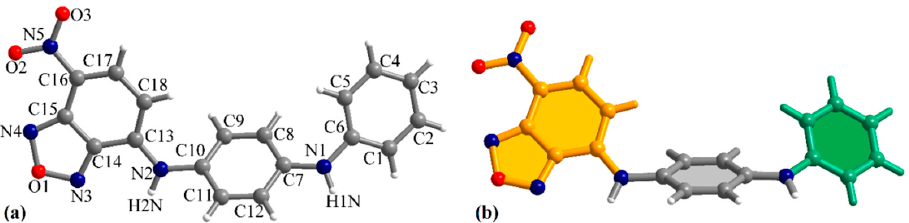
Figure 2. ( a ) View of the asymmetric unit in the crystal structure of compound 1 and ( b ) schematic representation of the planar moieties.